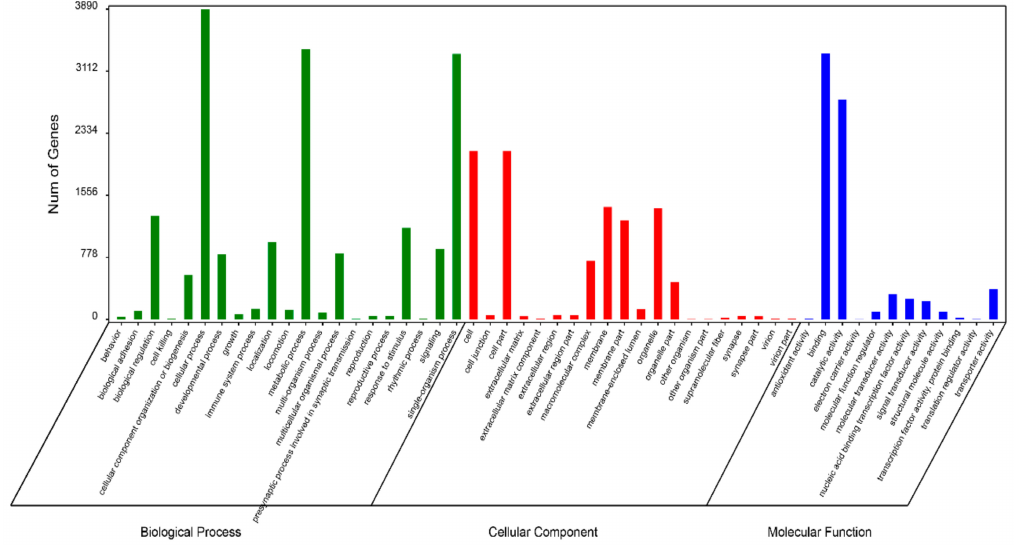
Figure 3. Functional annotation of all unigenes based on GO categorization. The X-axis and Y-axis indicate the GO functions and the number of unigenes with GO function,